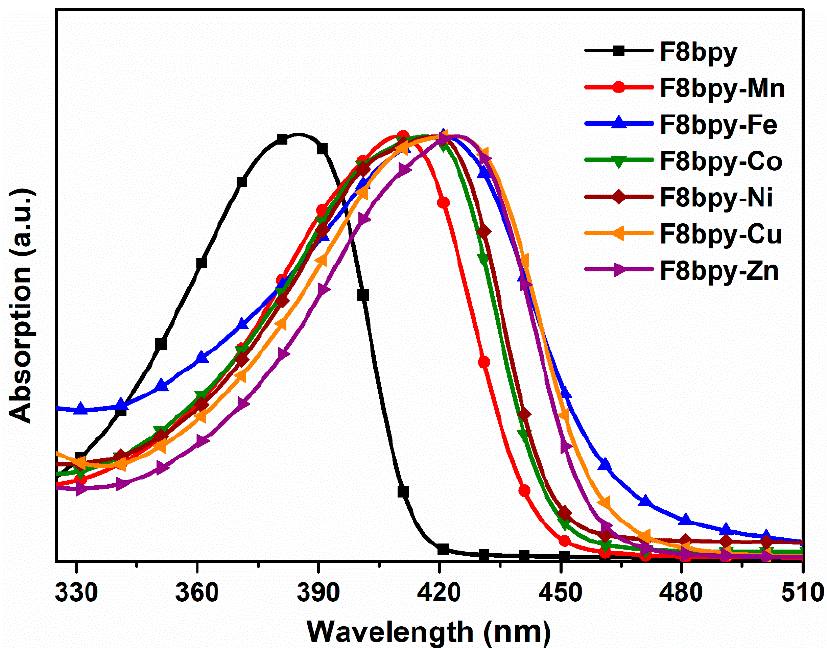
Figure 3. UV-vis absorption spectra of F8bpy/metal complex in chlorobenzene.